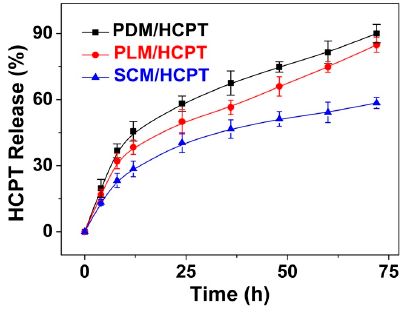
Figure 6. Release behaviors of PDM/HCPT, PLM/HCPT, and SCM/HCPT in PBS at pH 7.4, 37 °C. Each set of data is presented as mean ± standard deviation (SD; n = 3).